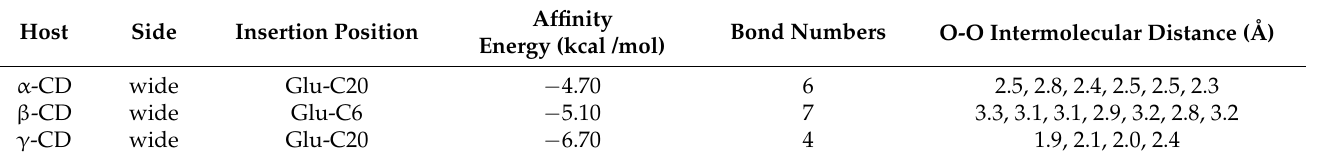
Table 2. The hydrogen bond formations between the guest (CDs) and the host molecule